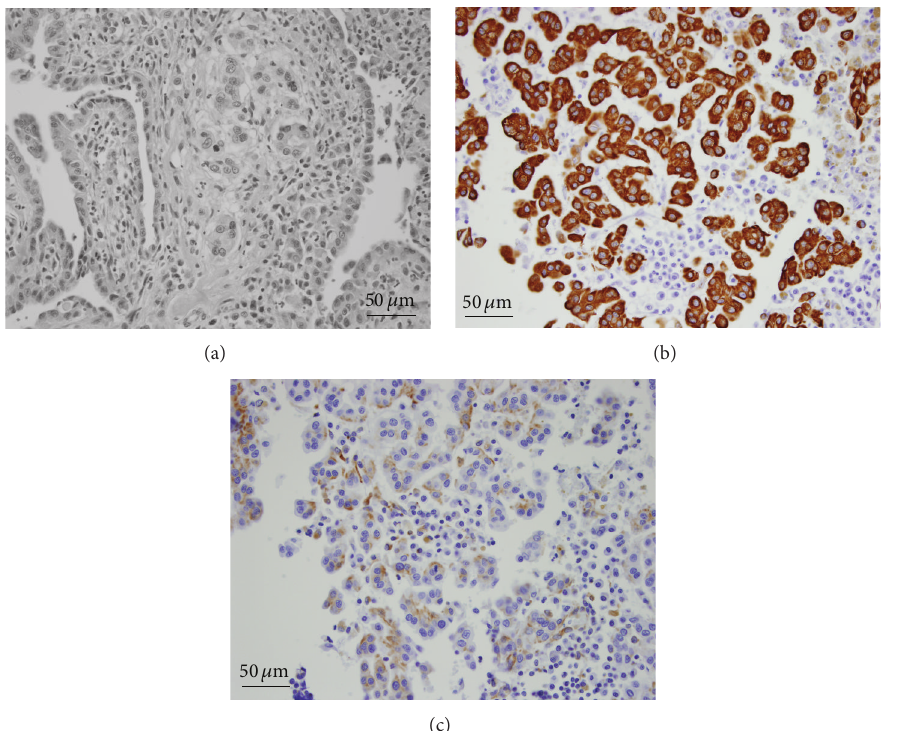
Figure 3: Photomicrographs of a mass overlying the epicardium and main pulmonary artery from a 15-year-old cougar. (a) Multiple papillary structures of fibrovascular stroma and nests of anisocytotic pleomorphic polygonal cells are covered by pleomorphic anisocytotic cuboidal to columnar cells (hematoxylin and eosin stain). (b) Clustered and individual cells strongly stain brown for the presence of cytokeratin intermediate filaments (immunohistochemistry, cytokeratin [AE1/AE3] antibody, DAB chromagen, hematoxylin counterstain). (c) The same clustered and individual cells stain brown for the presence of vimentin intermediate filaments (immunohistochemistry, vimentin [V9] antibody, DAB chromagen, hematoxylin counterstain). All figures are at 40x objective. Bar = 50 𝜇